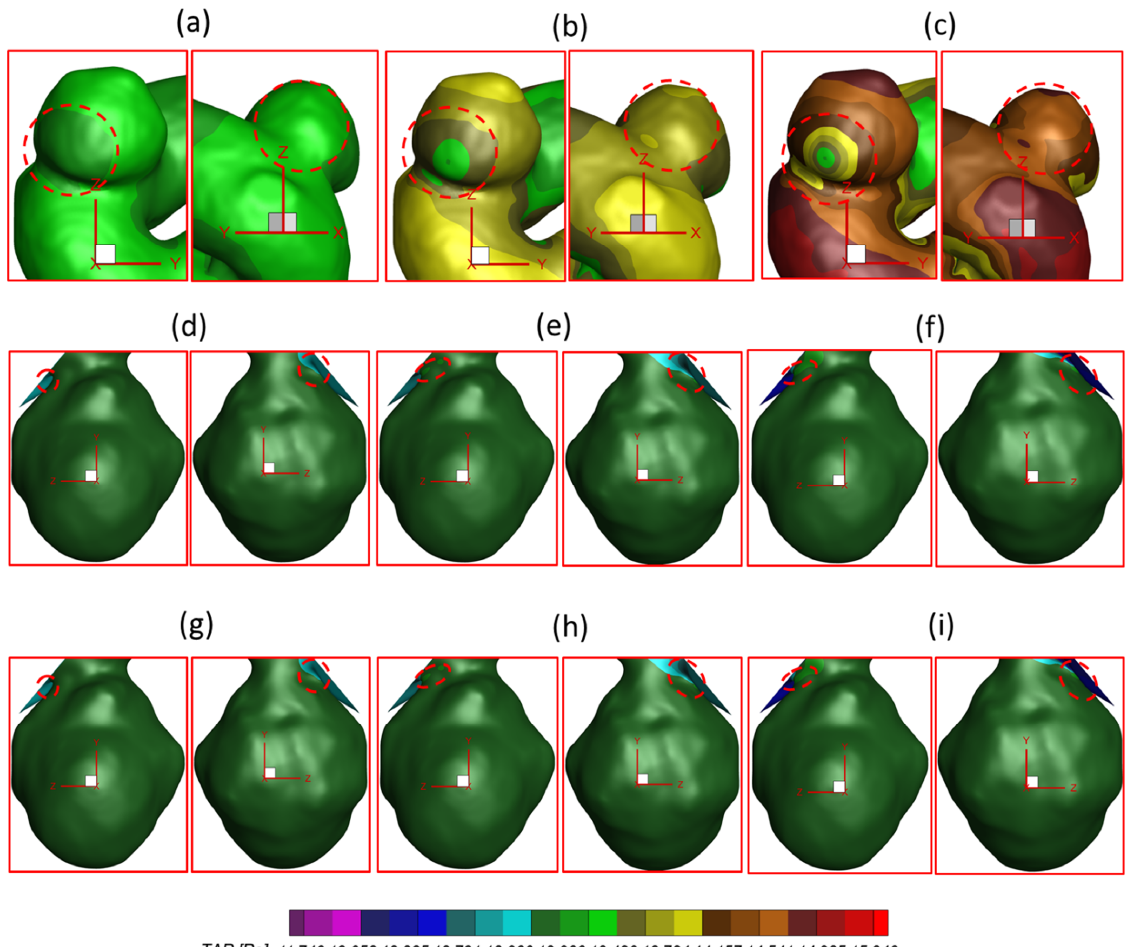
Figure 11. (cid:1846)(cid:1827)(cid:1842) distributions on the arterial walls of ICASA models: ( a ) ICASA−1, q A1 :q A2 = 75:25, Figure 11. TAP distributions on the arterial walls of ICASA models: ( a ) ICASA − 1, q A1 :q A2 = 75:25, and PFR−I, ( b ) ICASA−1, q A1 :q A2 = 75:25, and PFR−II, ( c ) ICASA−1, q A1 :q A2 = 75:25, and PFR−III, ( d ) and PFR − I, ( b ) ICASA − 1, q A1 :q A2 = 75:25, and PFR − II, ( c ) ICASA − 1, q A1 :q A2 = 75:25, ICASA−2, q A1 :q A2 = 75:25, and PFR−I, ( e ) ICASA−2, q A1 :q A2 = 75:25, and PFR−II, ( f ) ICASA−2, q A1 :q A2 = 75:25, and PFR−III, ( g ) ICASA−2, q A1 :q A2 = 64:36, and PFR−I, ( h ) ICASA−2, q A1 :q A2 = 64:36, and PFR−II, and ( i ) ICASA−2, q A1 :q A2 = 64:36, and PFR−III. Table 4. (cid:1846)(cid:1827)(cid:1842) (Pa) in aneurysmal regions (R1 and R2) under different PFRs and shunt ratios. TAP (Pa) Selected Region q A1 :q A2 Pulsatile Flow Rate Minimum Maximum ICASA−1 (R1)